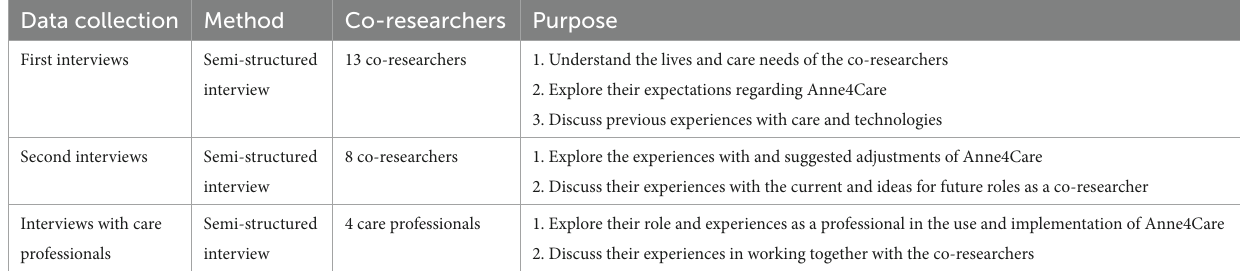
TABLE 1 Three steps of data collection, method, number of included co-researchers, and purpose of each step. Data collection